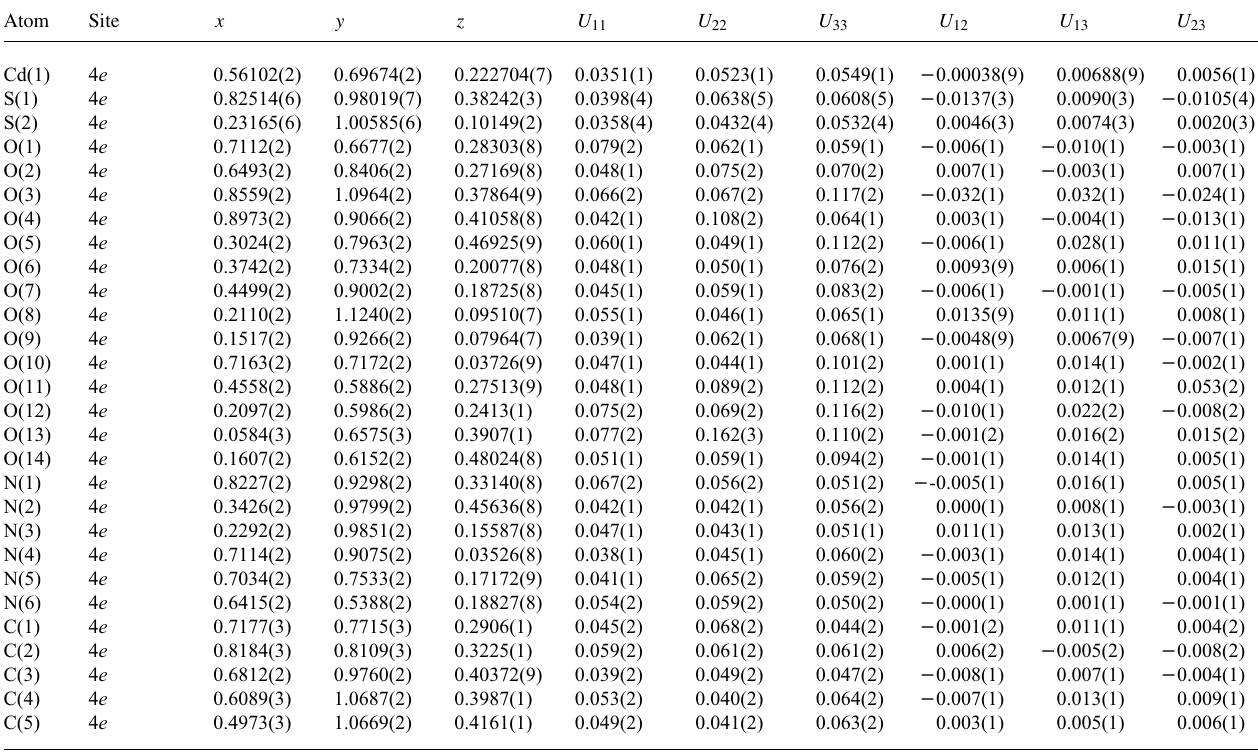
Table 3. Atomic coordinates and displacement parameters (in Å 2 ) .